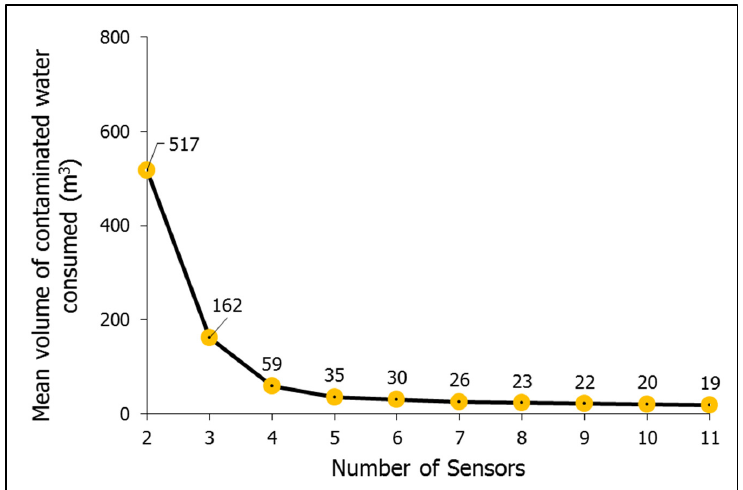
Figure 4. Mean volume of contaminated water consumed before detection during a contaminant intrusion event versus number of sensors under a normal scenario ( 𝜂 (cid:3028)(cid:3047)(cid:3047)(cid:3028)(cid:3030)(cid:3038) = 0). Table 1. Impact values obtained with and without cyber-physical attack of WQ sensors. Number of Sensors